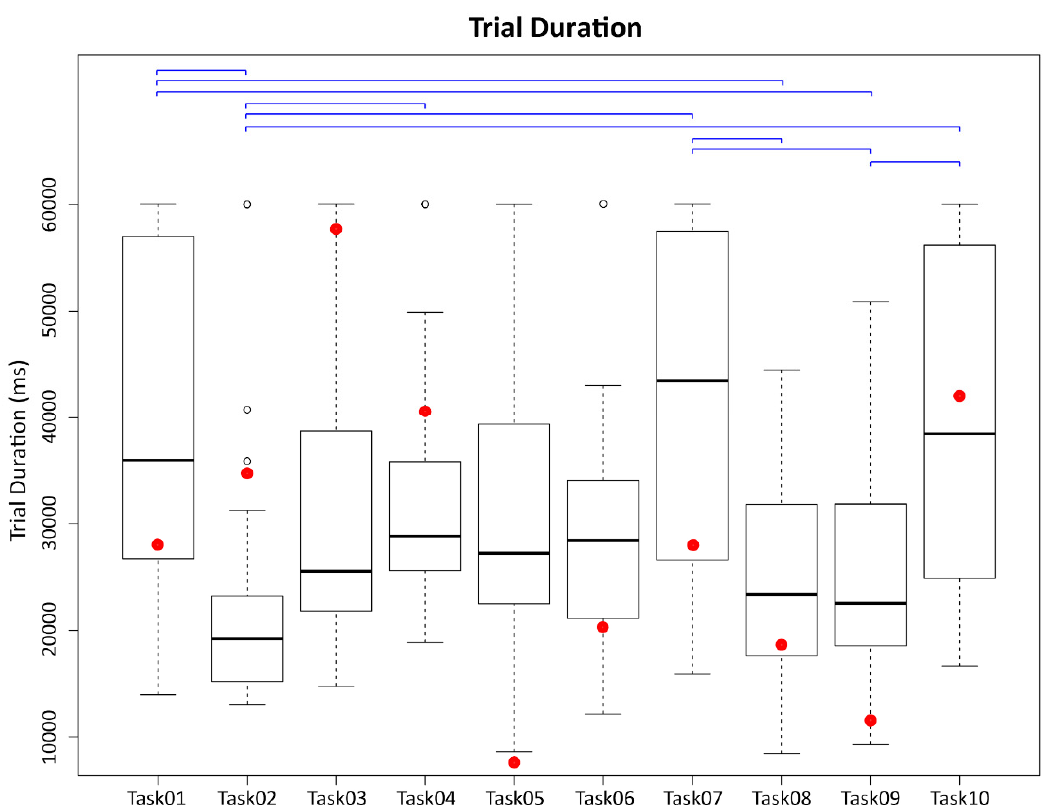
Figure 5. Trial duration for 30 students and the experiment’s tasks. The red dot indicates the geography teacher’s answers.